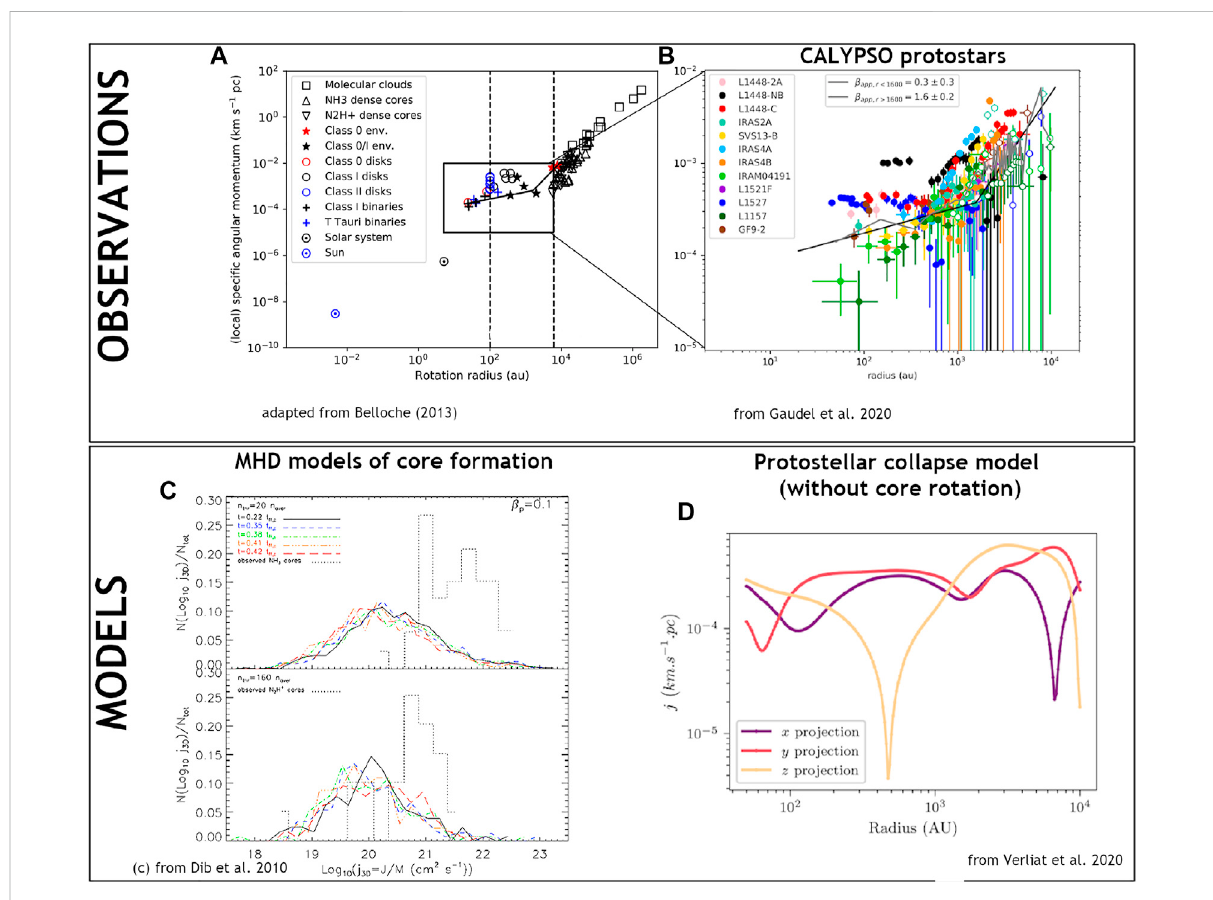
FIGURE 9 Observations and models of the angular momentum at core scales and disk scales. The upper row shows measurements of the gas angular momentum from observations of (A) star forming structures from Belloche (2013) and (B) of Class 0 young protostars from Gaudel et al. (2020). The lowerrowshowsangular momentumfromthegasin (C) modelsofcoresfromDibetal.(2010)and (D) modelsofyoung protostars fromVerliatetal.